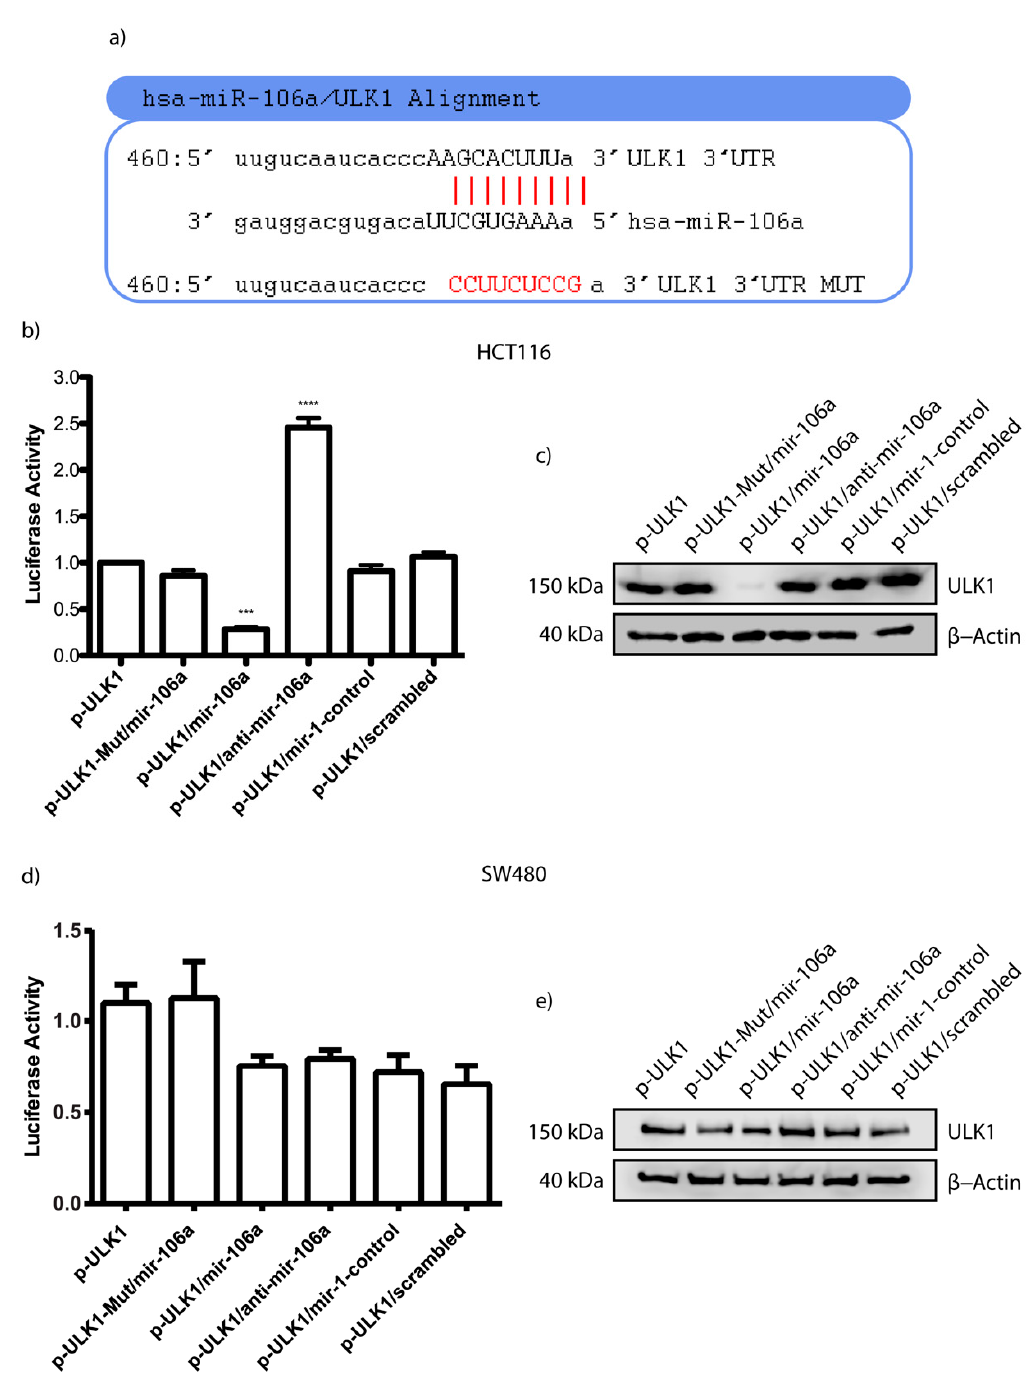
Figure 3. Validation of miR-106a target by Luciferase assay. ( a ) Bioinformatics analyses predicted the binding sites between ULK1 and miR-106a. ( b , d ) Luciferase reporter assay was performed to demonstrate the relationship between ULK1 and miR-106a in HCT116 and SW480 cells using the miR-106a/ULK1 interaction region normalized with an empty vector. ( c , e ) Detection of the ULK1 protein in the presence of miR-106a. Data are reported as the mean ± SD of three independent experiments. *** p < 0.001; **** p < 0.0001.